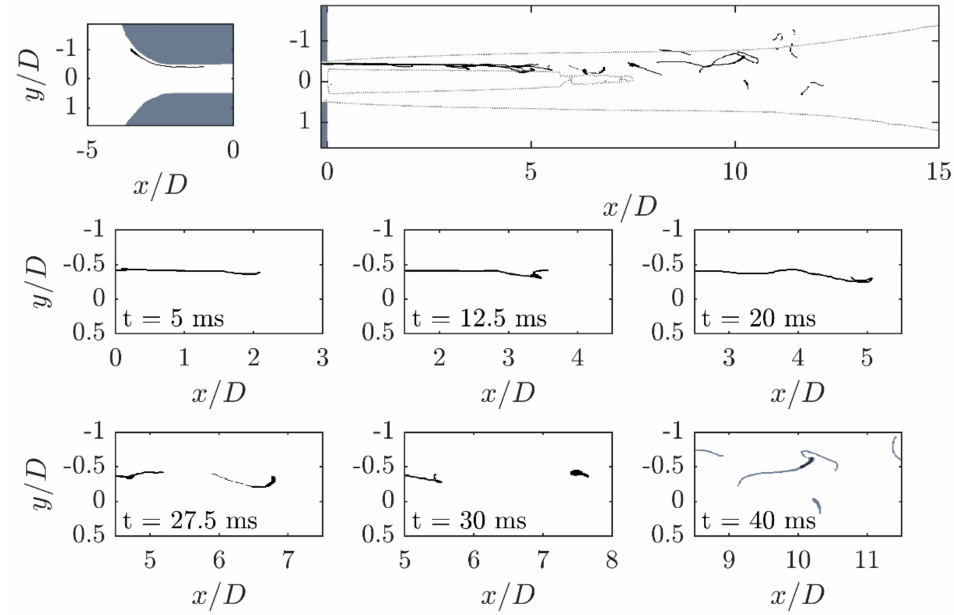
Figure 9. Evolution of a droplet passing through the orifice inside the shear layer (r ∗ = 0.9 )